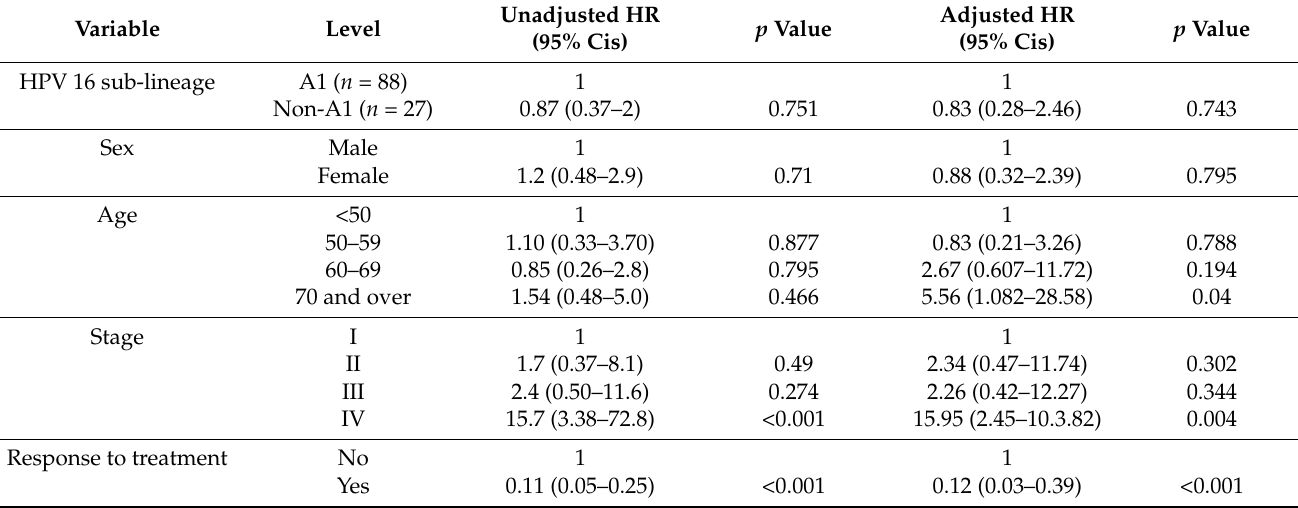
Table 4. Hazard ratio of HPV 16 sub-lineages (univariate and multivariate) derived from Cox regression ( N = 115) in anal cancer samples collected between 2009 to 2018 in the southeast of Scotland.